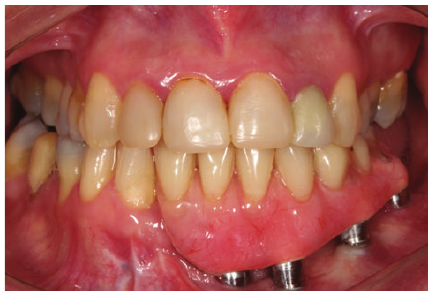
Figure 10: Six-year follow-up after tumor resection, clinical view.